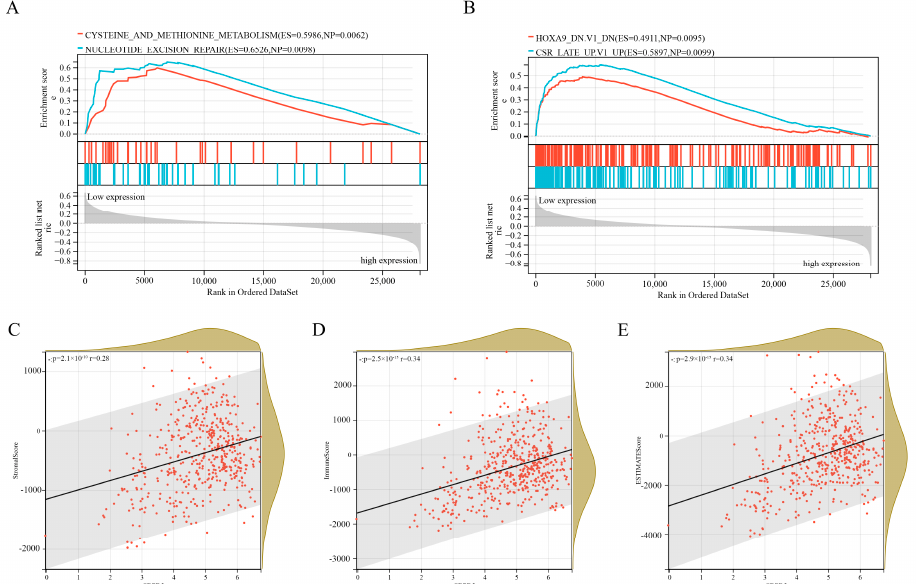
Figure 4. Gene Set Enrichment Analysis (GSEA) and immune infiltration analysis of GDPD5. ( A )